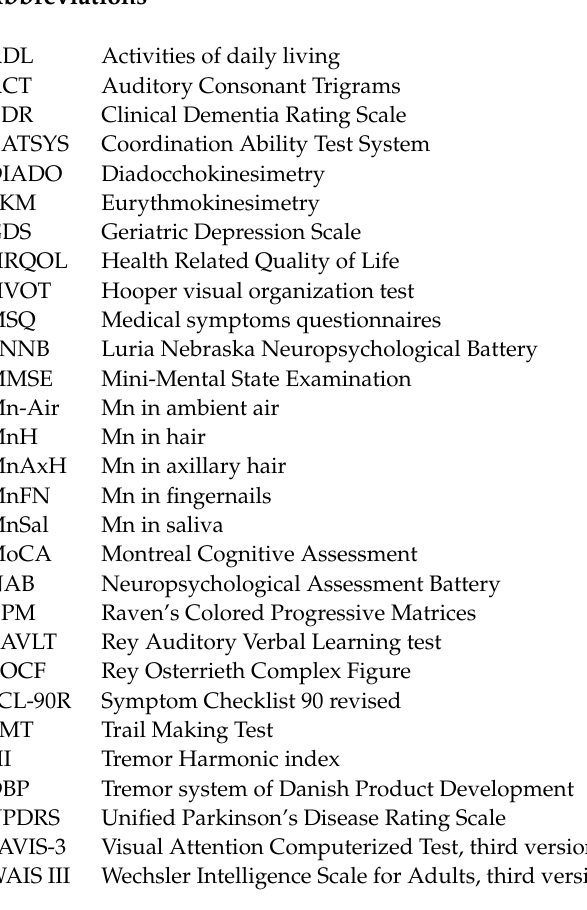
tests and all exposures to Mn. Figure S12. Motor function. Standardized mean differences (SMDs) between groups, as a function of the motor test used. Figure S13. Motor function. Standardized mean differences (SMDs) between groups, as a function of the motor domain assessed. Figure S14. Motor function. Standardized mean differences (SMDs) between groups, as a function of the type of exposure to Mn